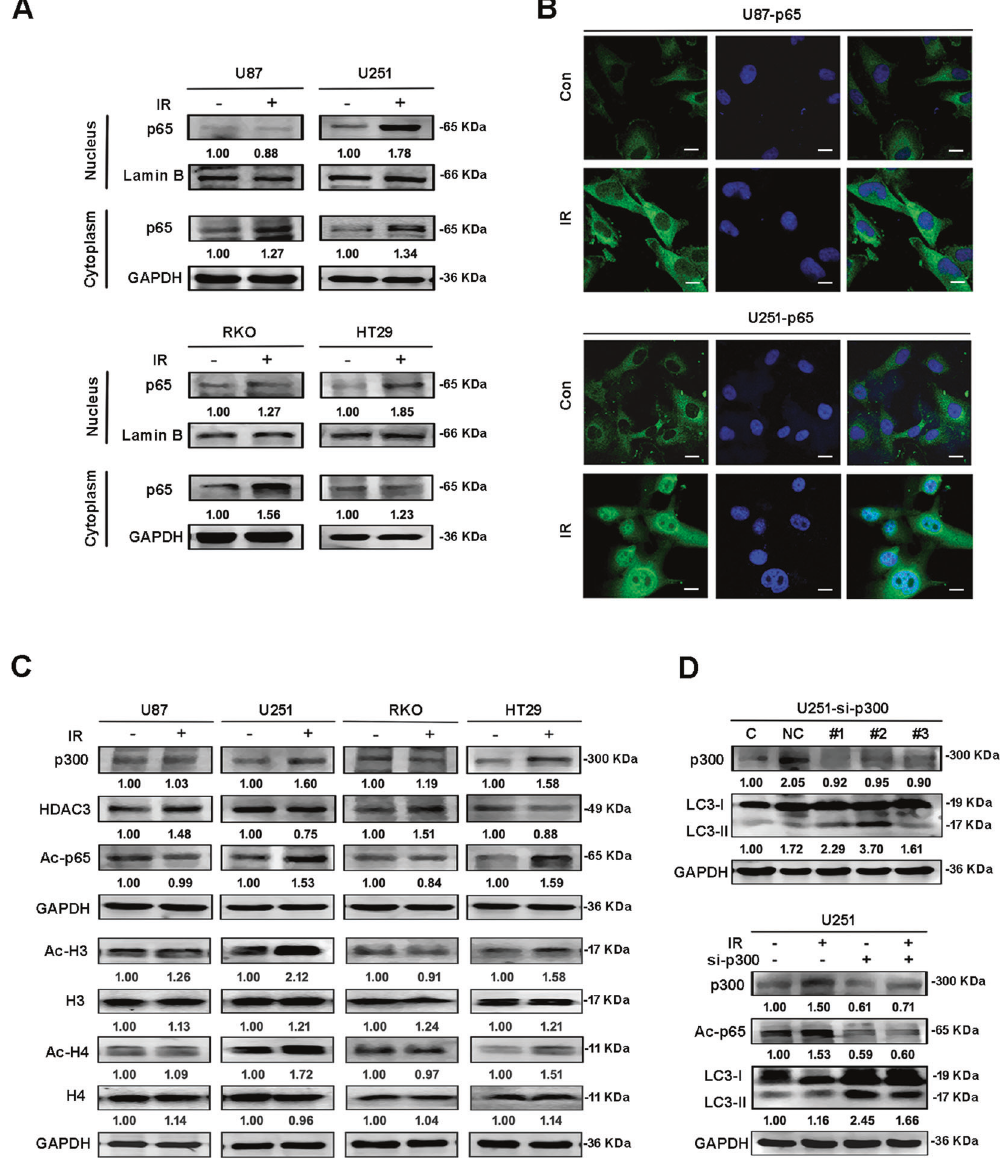
U87, U251, RKO, and HT29 cells. B Immuno fl uorescence further veri fi ed the localization changes of p65 in U87 and U251 cells before and after IR (×630). C Western blotting was used to analyze the changes of p300, Ac-p65, HDAC3, Ac-H3, H3, Ac-H4, and H4 proteins after IR in the cell lines. D P300 and LC3 protein levels were detected by interfering with p300 in U251 cells with interference chains, then western blotting was used to analyze the changes of p300, Ac-p65, and LC3 proteins by 12 h after the interference of p300 in U251 cells. Table